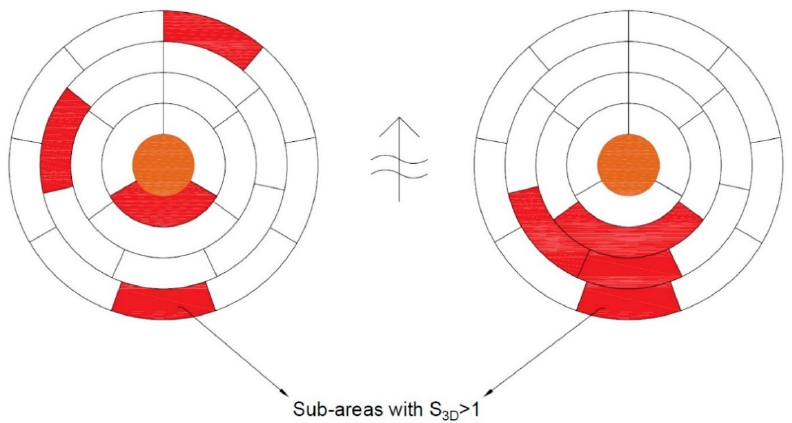
Figure 2. Example of different scour exposures for the same S 3D > 1.00—left Protection: Less prone to filter exposure; right Protection: More prone to filter exposure, because the damage is gathered in the same region, adapted from Reference [4].